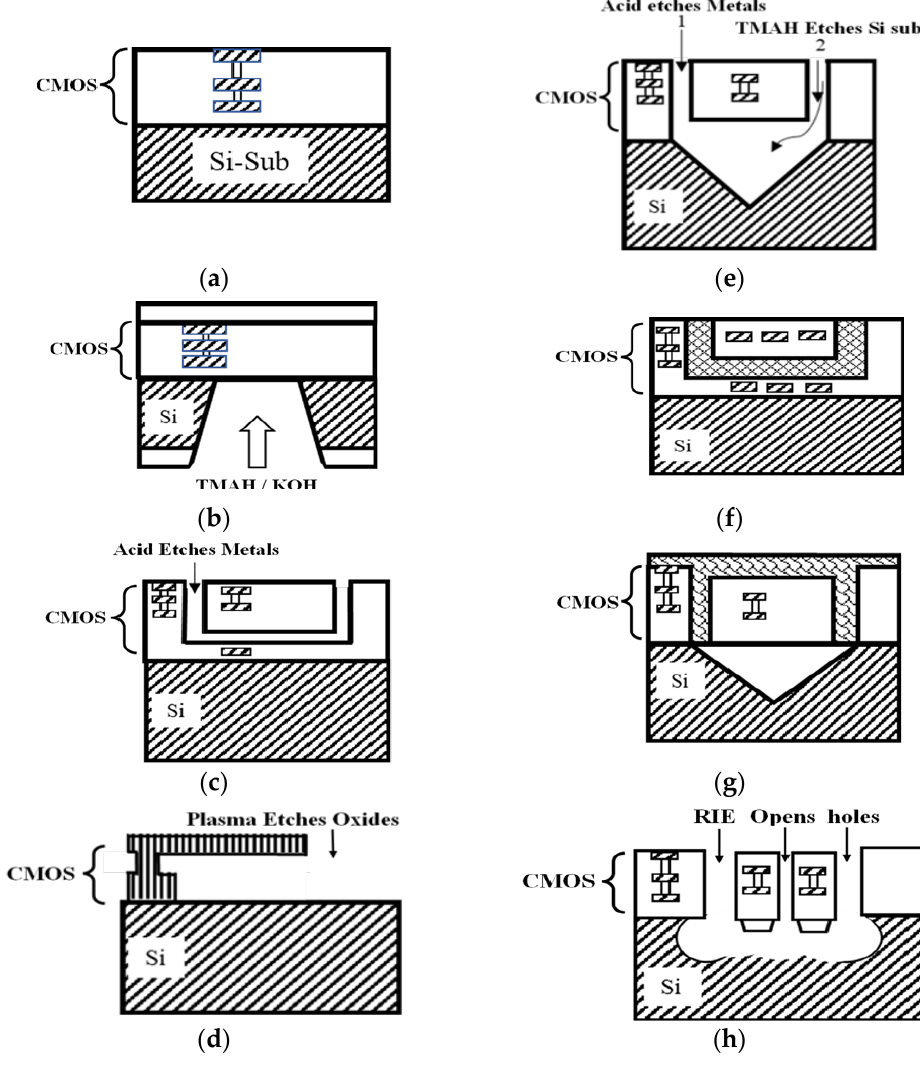
Figure 5. Post-processes ever used for CMOS MEMS in Taiwan: ( a ) CMOS silicon wafer; ( b ) backside wet etching using tetramethylammonium hydroxide (TMAH)/potassium hydroxide (KOH) for bulk micromachining [91,165]; ( c ) acid etch metals (surface micromachining) [35,37]; ( d ) deep trench plasma etching the oxides to release the cantilever [130]; ( e ) acid is used to etch metals and TMAH used to etch the Si substrate [57]; ( f ) electroplating Ni in the process ( c ) [90,137]; ( g ) parylene or gelatin is coated on process ( e ) [87,88]; ( h ) anisotropic and isotropic etching with STI protection [96,97,102,166].